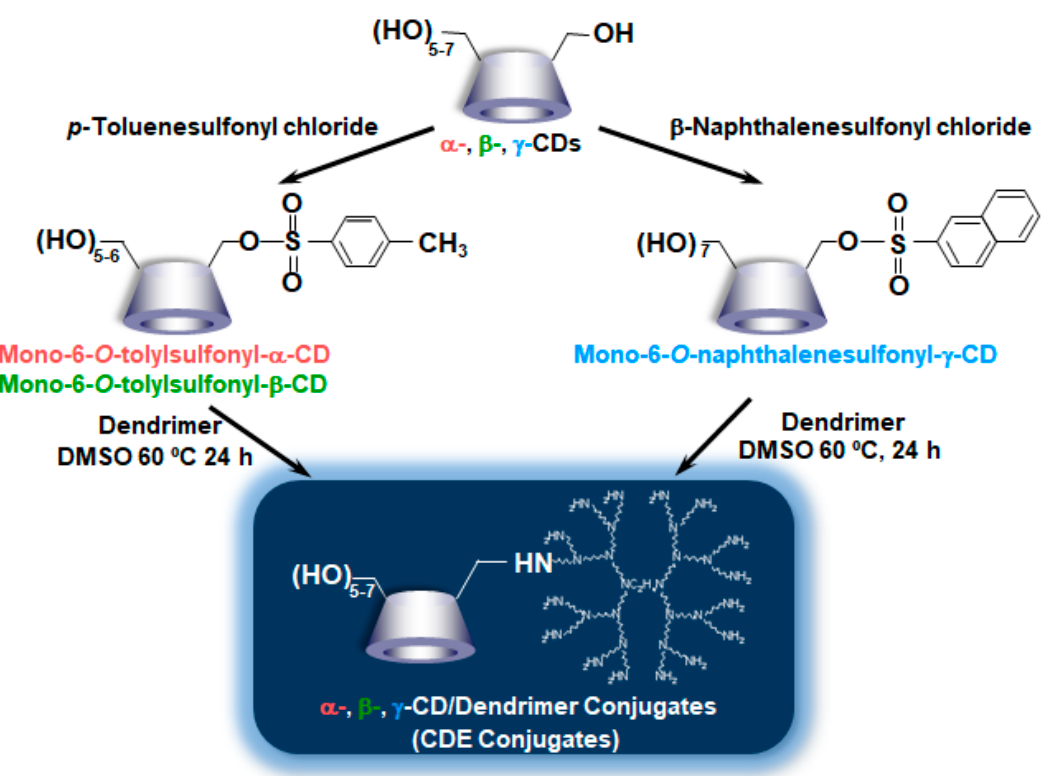
Figure 2. Scheme for preparation of α -CDE (G2, DSC1), β -CDE (G2, DSC1), and γ -CDE (G2, DSC1). Next, the effects of the generation of PAMAM dendrimers in α -CDE on gene transfer activity were investigated [38]. The gene transfer activity of α -CDEs (G2, G3, and G4, DSC1) was higher than that of the corresponding PAMAM dendrimer alone in NIH3T3 and RAW264.7 cells. Of three CDEs (G2, G3, and G4, DS1), α -CDE (G3, DSC1) had the highest superior gene transfer activity, which was comparable to that of TransFast ® in NIH3T3 cells. Remarkably, α -CDE (G3, DSC1) was suggested to improve endosomal escape after entering cells through the synergetic effects of the proton sponge effect of PAMAM dendrimer (G3) and interaction of α -CD in an α -CDE (G3, DSC1) molecule with biomembrane constituents such as phospholipids, possibly in endolysosomes after transfection. Although the detailed mechanism by which α -CDE (G3, DSC1) has superior gene transfer activity to α -CDE (G4, DSC1), the number of the primary amino group of the former is twice higher than that of the latter, hence suggesting that the proton sponge effect of the former should be higher than that of the latter. Cytotoxicity, as one of the possible reasons, might be involved in the unpredicted results, and therefore, a further elaborative study is necessary. Collectively, these results suggest that α -CDEs (G2, G3, and G4, DSC1), particularly α -CDE (G3, DSC1) could be novel nonviral gene transfer agents